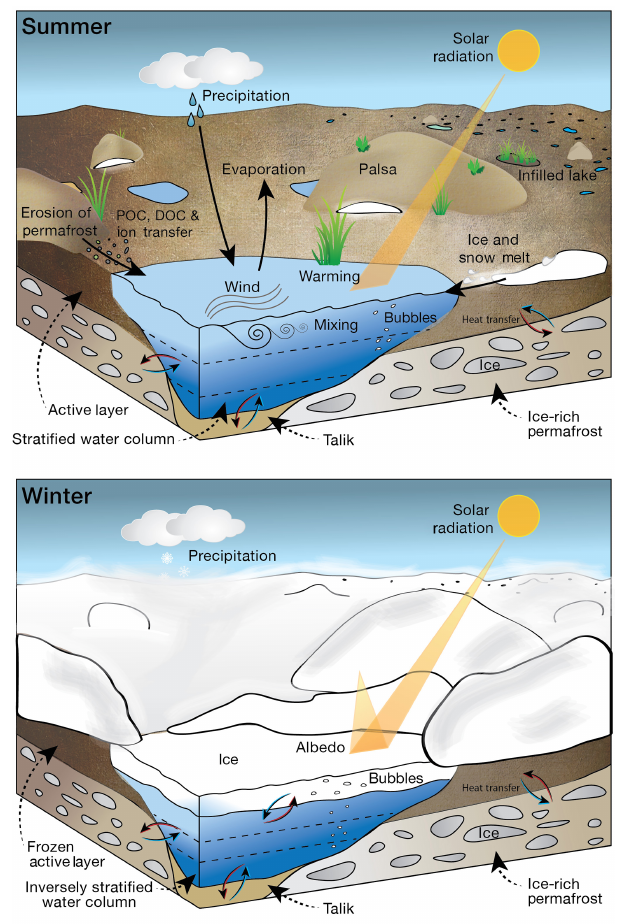
Figure 4. Physical limnological characteristics of permafrost thaw lakes in the ice-free and ice-covered seasons. Note that shallow ponds and lakes that freeze to the bottom in winter are not con- sidered in this